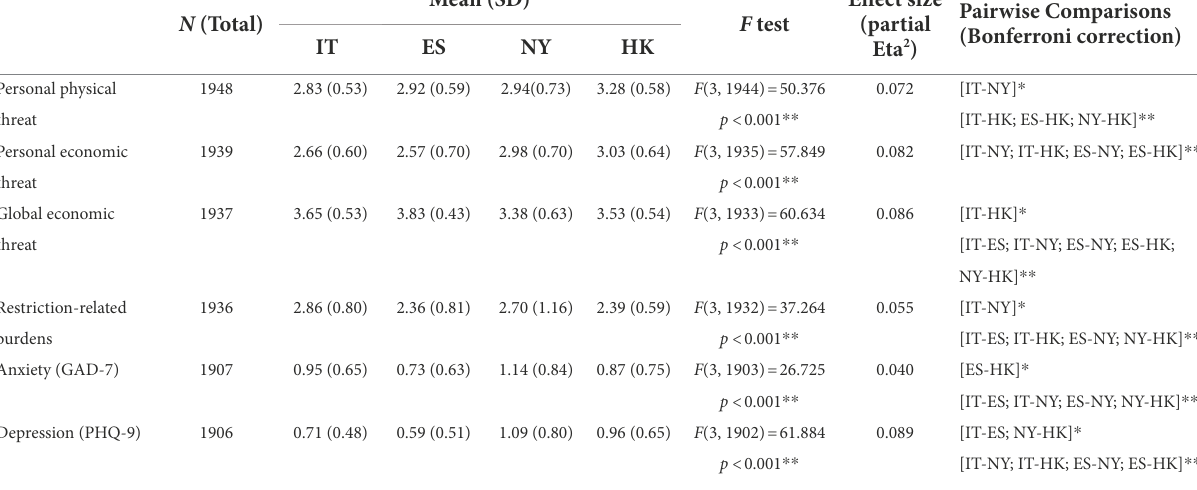
Pairwise Comparisons (Bonferroni correction)